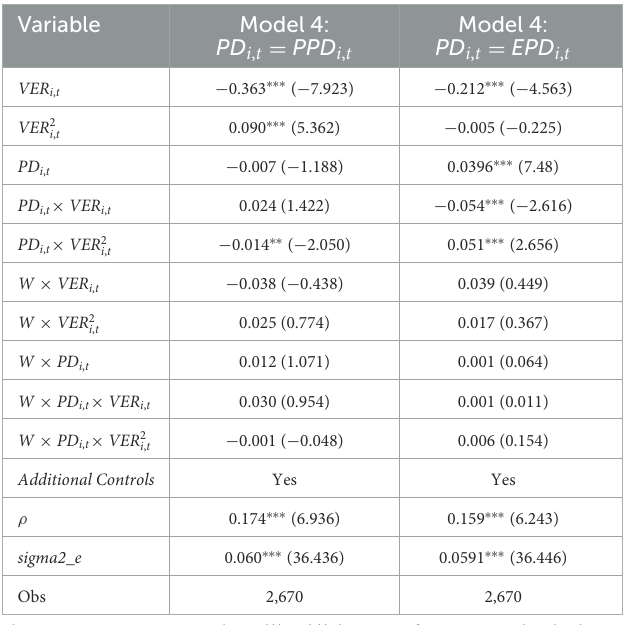
TABLE 7 Test results of moderating effect of PD on green governance effect of